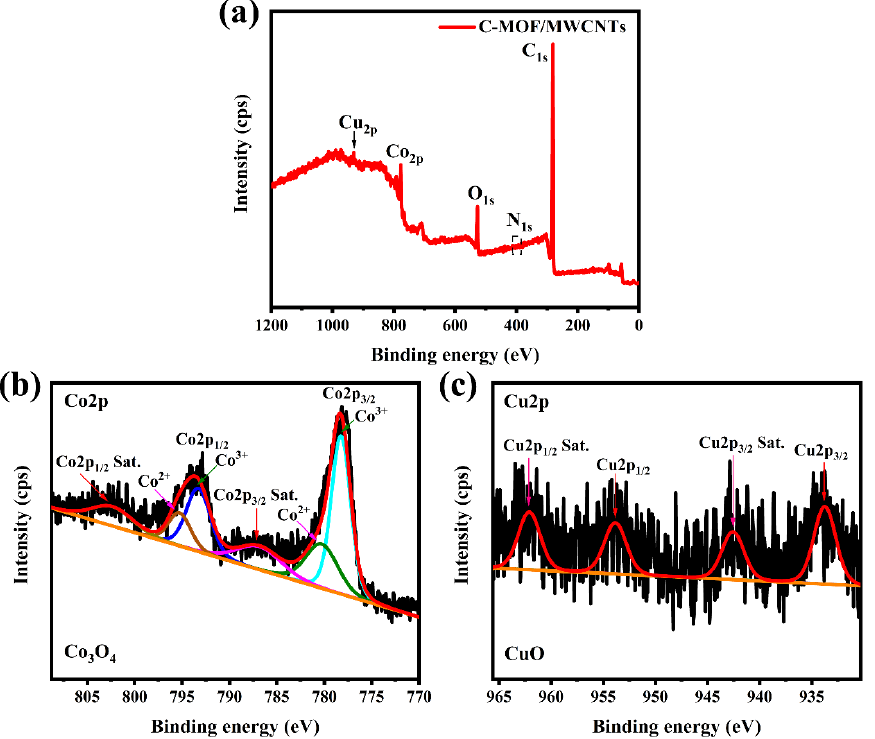
Figure 2. XPS curves of C-MOF/MWCNTs ( a ), its Co2p ( b ), and Cu2p ( c ).